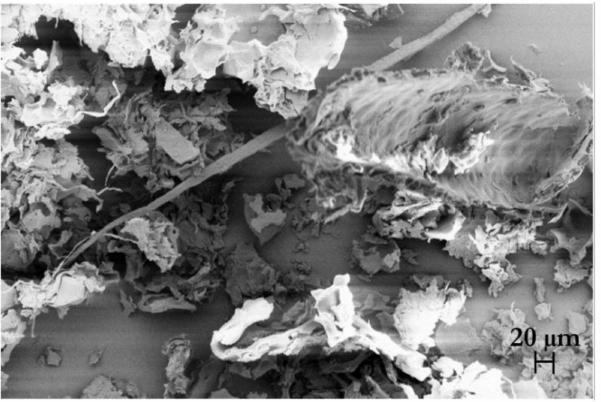
Figure 7. SEM micrographs at 300 × magnification of cellulose extracted from HPH-TP. Particle size distribution analysis showed that TP and HPH-TP isolated cellulose presented a unimodal distribution, with the main peaks located approximately at 630 µ m and 315 µ m, respectively (Figure 8). Moreover, the 90th percentile of TP and HPH-TP cellulose particles was around 1200 µ m and 600 µ m, respectively (Table 4). These results further suggest that HPH pretreatment was able to contribute to the disintegration of plant tissues, favoring the isolation of